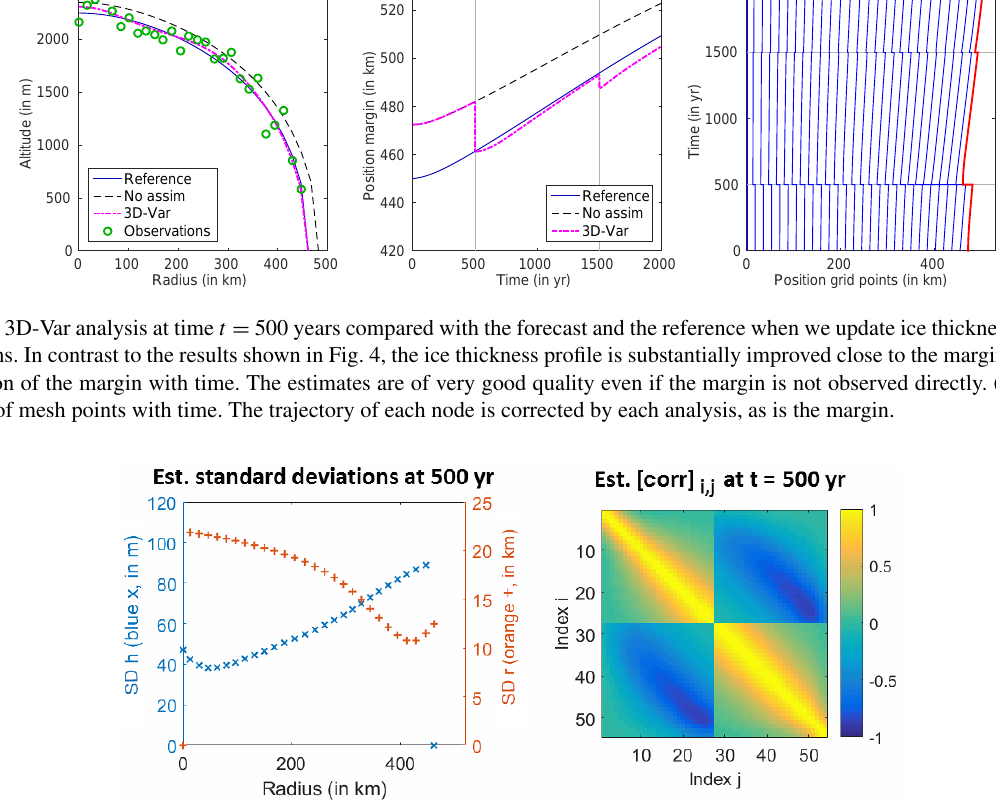
Figure 6. Standard deviations and correlation matrix Corr estimated from the 3D-Var analysis at time t = 500 years when we use only observations of ice thickness. Auto-correlations between ice thicknesses are located in the top left corner of Corr ; auto-correlations between node positions are in the bottom right corner. The rest of the matrix depicts the